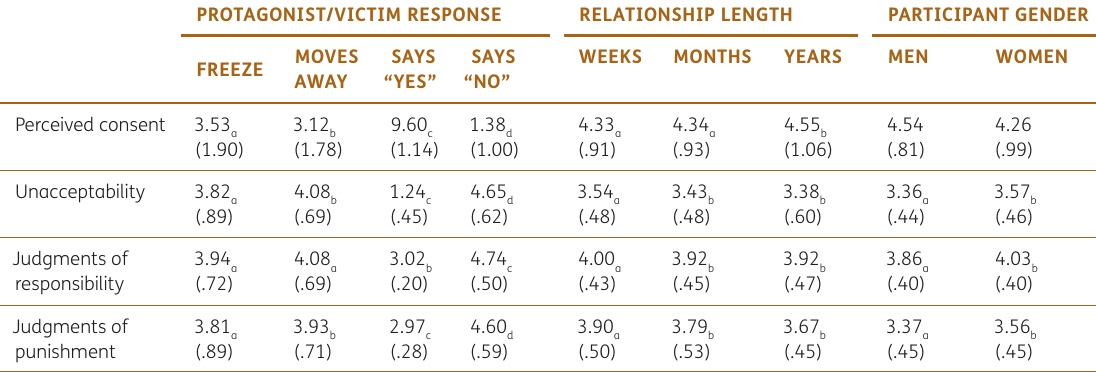
Table 2 Means (and SDs) for judgments by response, relationship length and sex. Note : Perceived consent was coded as 1 = definitely not consent to 10 definitely consent. Acceptability was coded from 1 = definitely OK to 5 definitely not OK; Judgments of responsibility and who should be punished were coded 1 = definitely the victim 3 neither or both and 5 definitely the perpetrator.